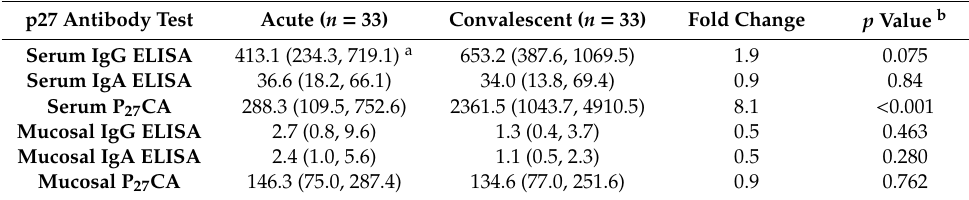
Table 2. p27 Antibody concentrations in acute and convalescent sera and nasal washes from RSV infected HCT